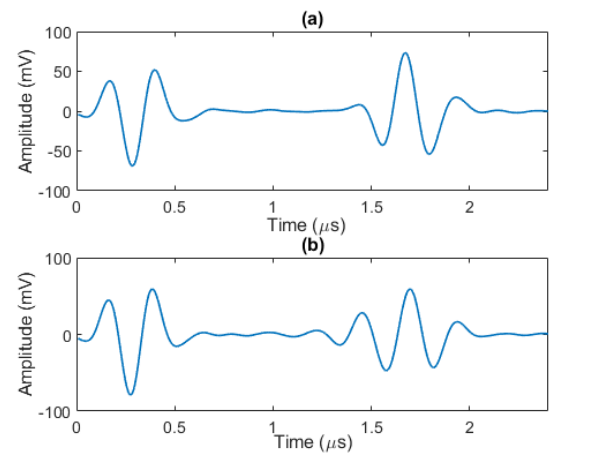
Figure 1. Two different A-scans using 5 MHz PA transducer: ( a ) at a non-defective location, and ( b ) at a location with defect close to back